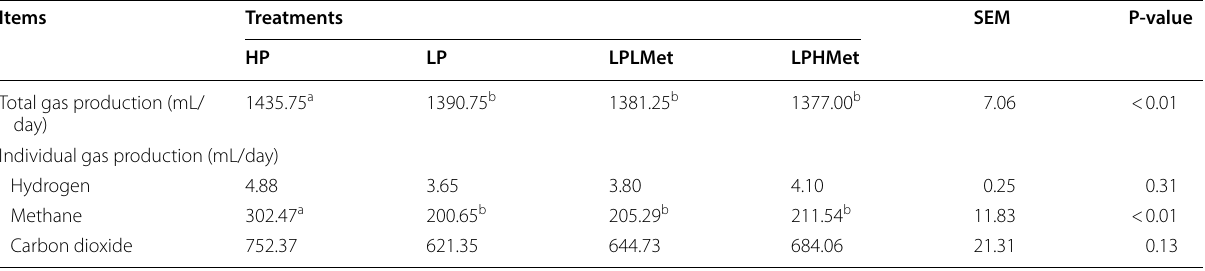
Table 6 Effects of supplementation of RPMet with low CP on daily production and composition of gases using a RUSITEC technique (n =